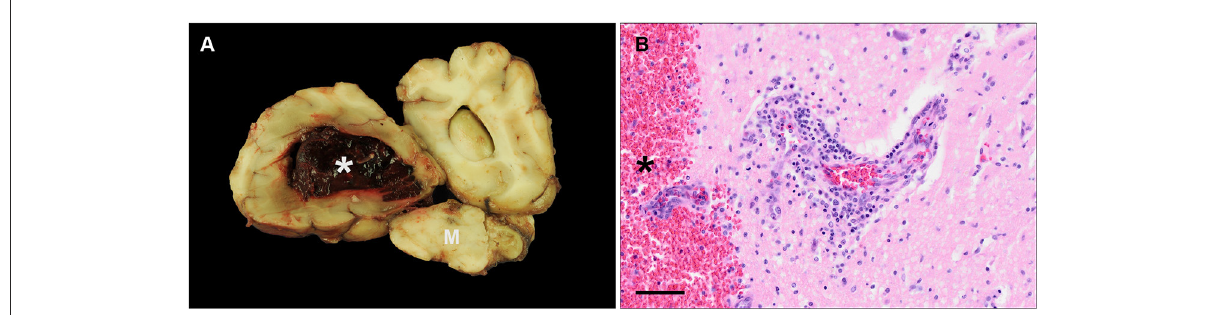
FIGURE3 Macroscopic and histopathological findings of a 10 year old, mixed breed dog (case 2). (A) Macroscopic image of a transverse section of the cerebrum including the cerebral hemispheres and parts of the mesencephalon (M). The lateral ventricle of the left hemisphere displays severe, focal hemorrhage (asterisk). (B) Histopathology of the same area displayed in (A) . A blood vessel shows moderate vasculitis and perivascular infiltrates consisting of lymphocytes and macrophages. The lateral ventricle and adjacent parenchyma reveal hemorrhage (asterisk) (HE stain; scale bar: 50 µ